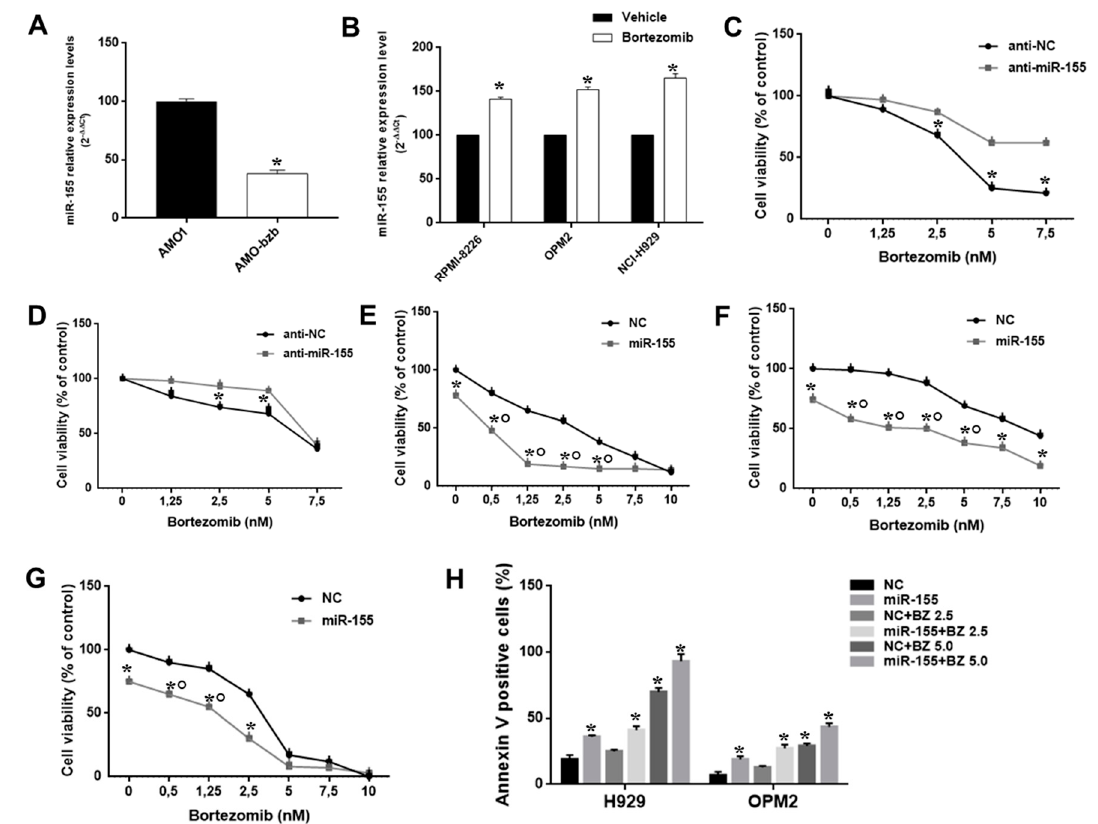
Figure 3. The miR-155 modulates bortezomib anti-MM activity in vitro. ( A ) Quantitative real time-PCR analysis of miR-155 using RNA from AMO-1 and AMO-bzb MM cell lines. Raw Ct values were normalized to RNU44 housekeeping snoRNA and expressed as percentage of miR-155 levels in AMO-1. ( B ) Quantitative RT-PCR analysis of miR-155 using RNA from RPMI-8226, OPM-2, and NCI-H929 cells treated with 2.5 nM bortezomib for 24 h. CCK8 assay performed on NCI-H929 ( C ) and OPM-2 MM cells ( D ) transfected with synthetic miR-155 inhibitors (anti-miR-155) or scrambled oligonucleotides (anti-NC), 48 hours after bortezomib treatment; * p < 0.05. CCK8 assay performed on RPMI-8226 ( E ), NCI-H929 ( F ), and OPM-2 MM cells ( G ) transfected with synthetic miR-155 or scrambled oligonucleotides (NC), 48 hours after bortezomib treatment; * p < 0.05, indicates synergistic combination (CI>1). ( H ) Apoptosis evaluation of NCI-H929 and OPM-2 MM cells transfected with synthetic miR-155 or scrambled oligonucleotides (NC), 48 h after treatment with different doses of bortezomib; * p < 0.05 as compared to NC-transfected